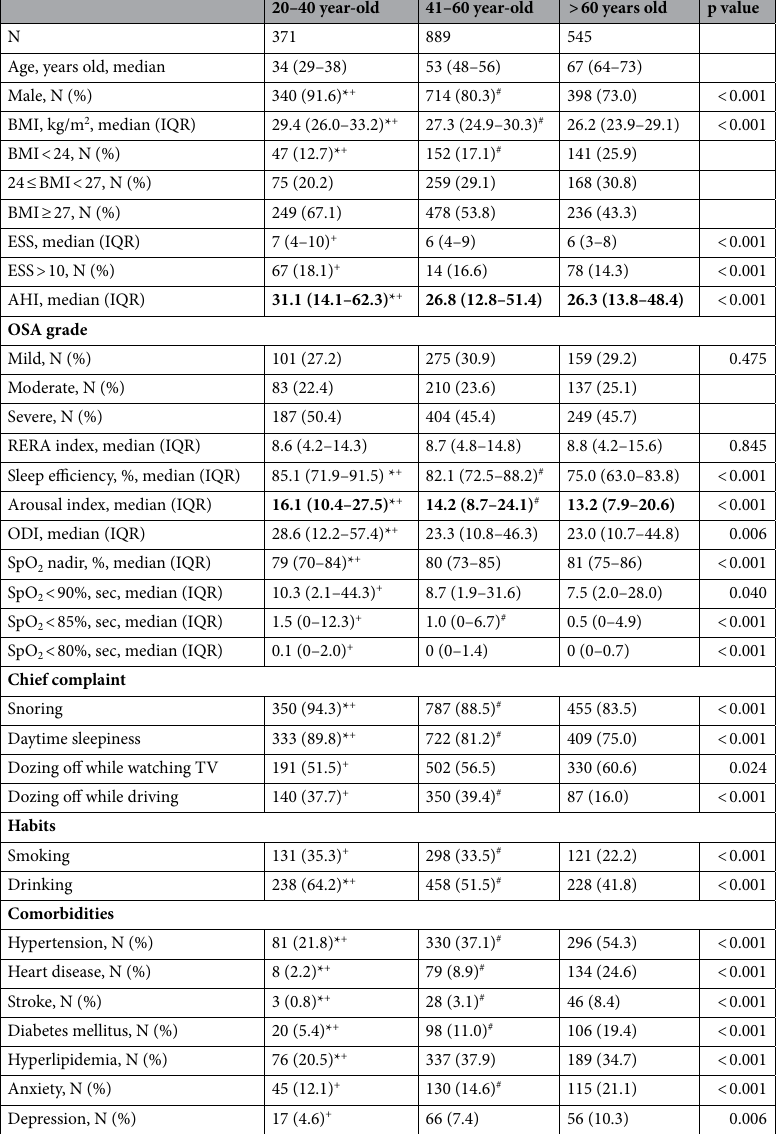
Table 2. Characteristics of patients with OSA. AHI apnea–hypopnea index, BMI body mass index, CSA central sleep apnea, ESS Epworth sleepiness score, IQR interquartile range, ODI oxygen desaturation index, RERA respiratory effort related arousal. Significant values are given in bold. *Post-hoc p < 0.017 young adults (20–40 years) v.s. middle age adults (40–60 years). + Post-hoc p < 0.017 young adults v.s. older adults (> 60 years). # Post-hoc p < 0.017 middle age adults v.s. elder